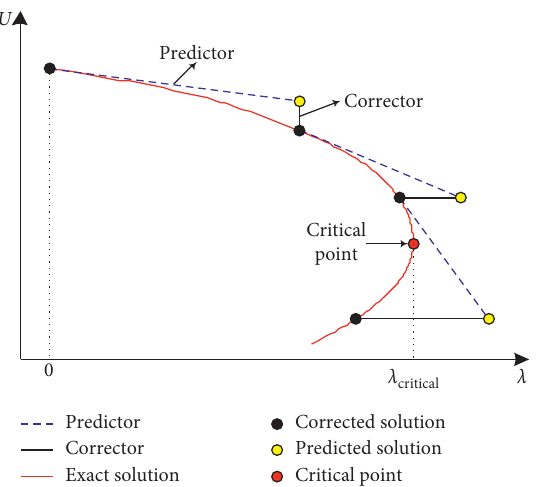
Figure 1: The predictor-corrector procedure of continuation power